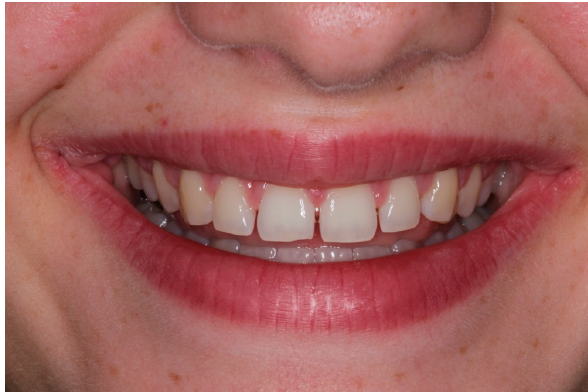
Figure 4. Case 2 preoperative photograph.